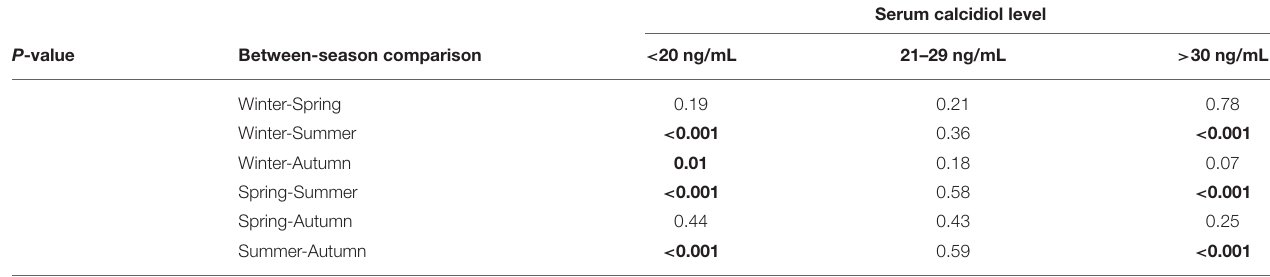
TABLE 6 | Between-season comparison of vitamin D levels.